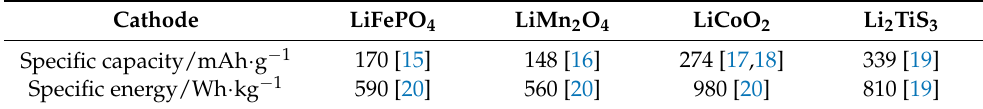
Table 1. Theoretical specific capacity and specific energy values of some